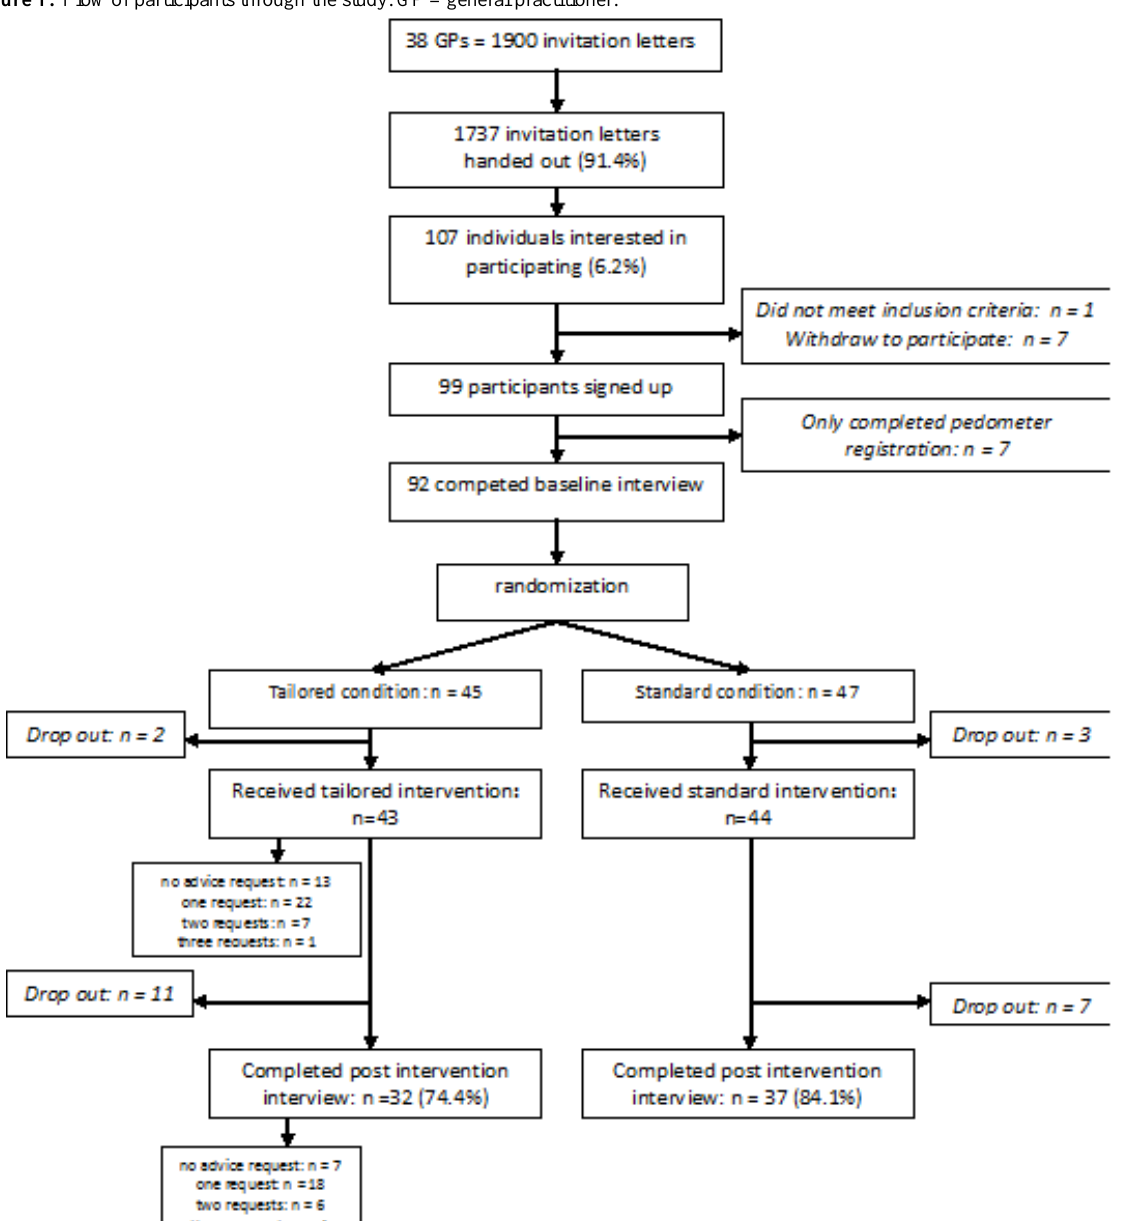
Figure 1. Flow of participants through the study. GP = general